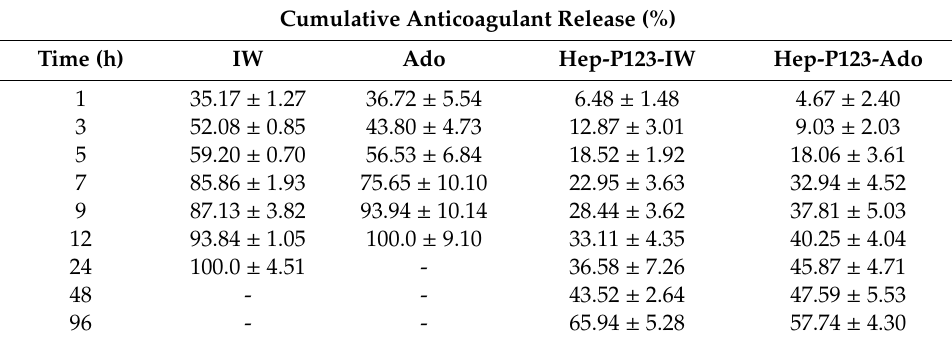
Figure 5. Release profiles of the free and encapsulated in Hep-P123 anticoagulants at physiological conditions pH 7.4 (37 ± 1 °C; n =3). Table 1. Cumulative anticoagulant release in in vitro